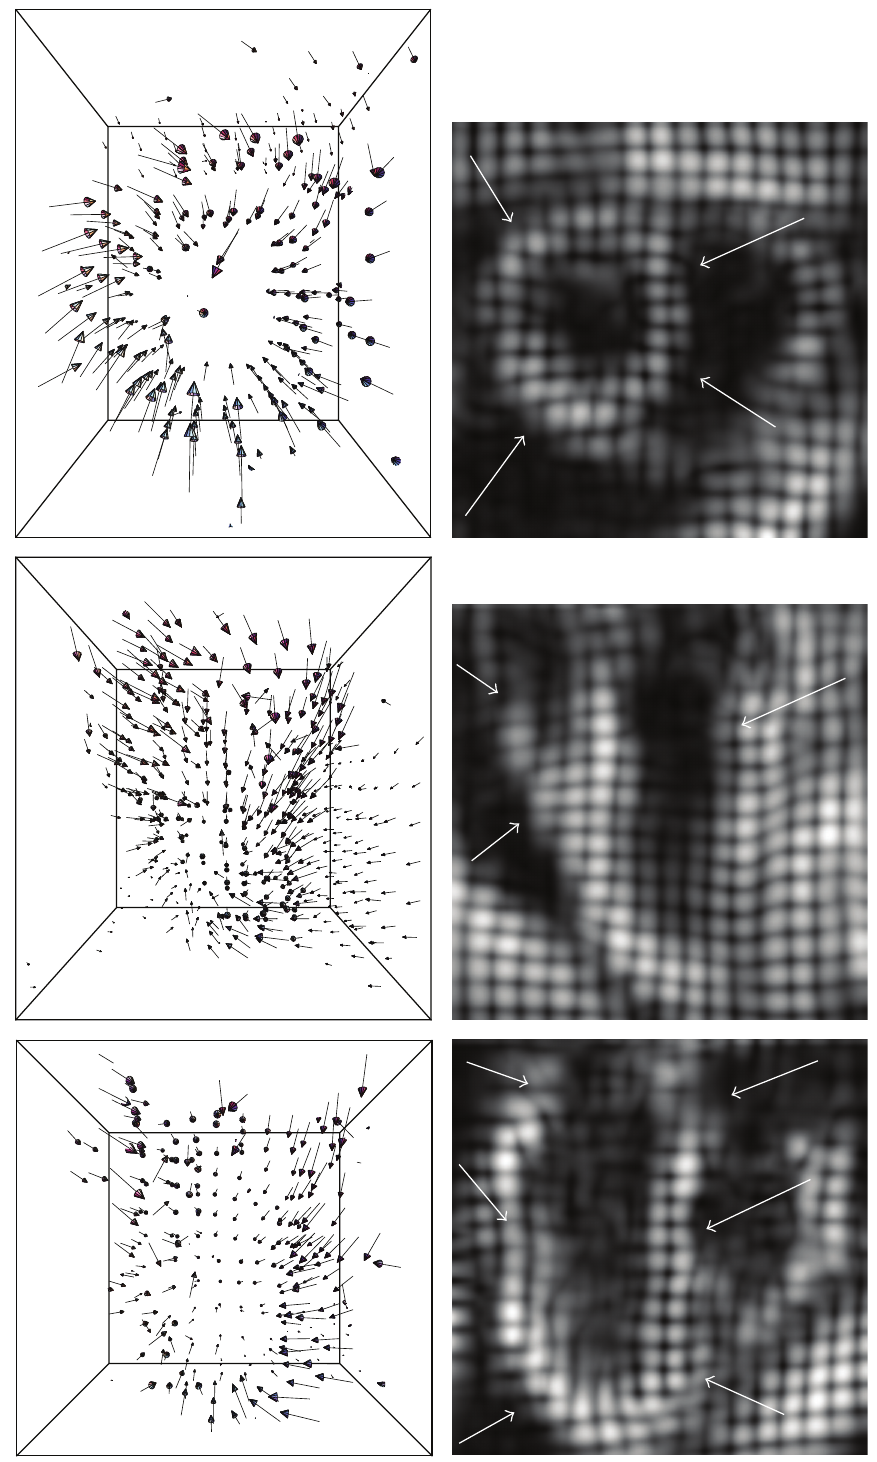
Figure 7: Three-dimensional velocity flow field of one frame of the left ventricle in phase of contraction (column 1) under 3 di ff erent views and the correspondent cross-sections of the cardiac image volume (column 2). In column 2, the left ventricle is highlighted by white arrows. Row 1 displays the short axis view, whereas rows 2 and 3 show the 2 long axis views. The retrieved 3-dimensional vectors illustrate with accuracy the cardiac motion behavior and overcome shortcomings typical of the 2-dimensional optic flow methods, such as through-plane motion